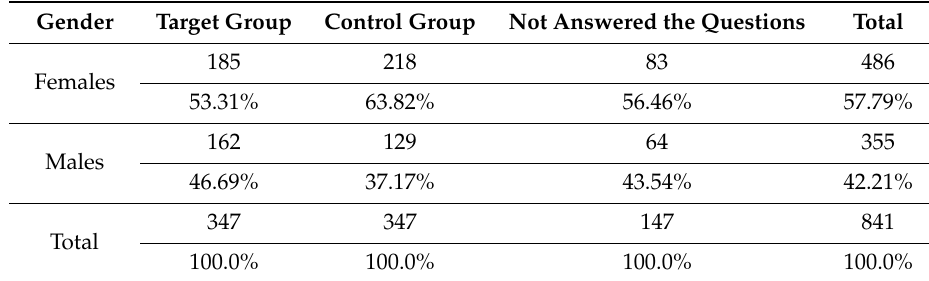
Table 1. Distribution of respondents by gender (N,